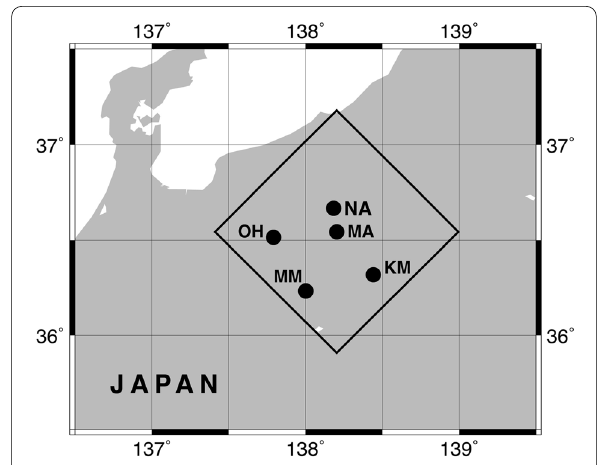
Fig. 1 Locations of gravimeter and barometer stations used in this study. For station codes, see Table 1. The square indicates the area in which Newtonian attraction by the atmospheric mass is calculated. Atmospheric waves from the Tonga volcano travel from the south-east direction through the north-west direction